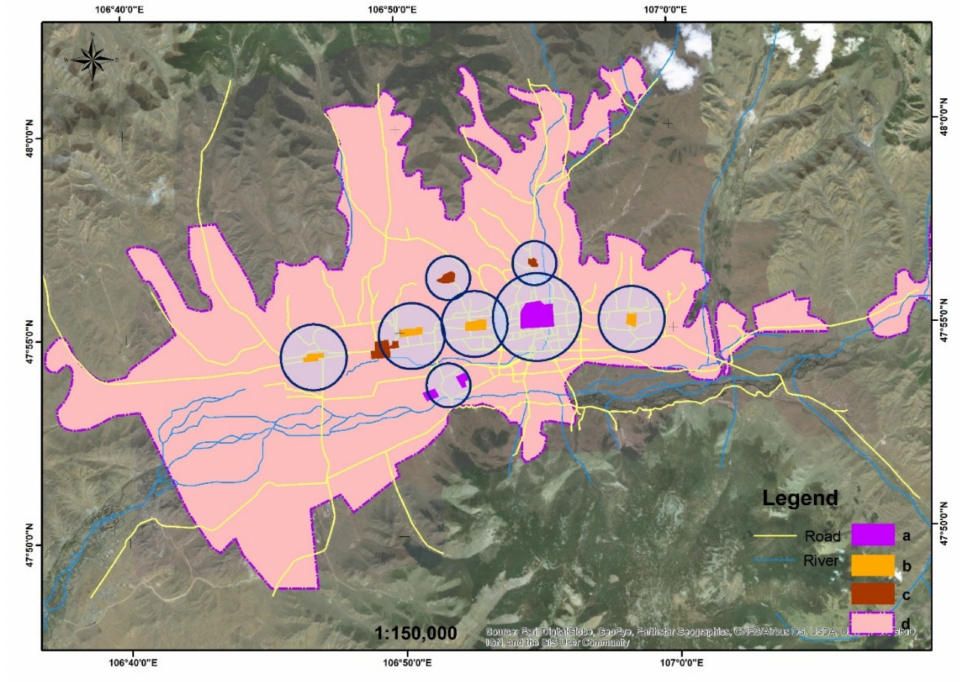
Figure 6. Planned polycentric concept. ( a ) city center; ( b ) district center; ( c ) planned sub-centers, ( d ) area suitable for